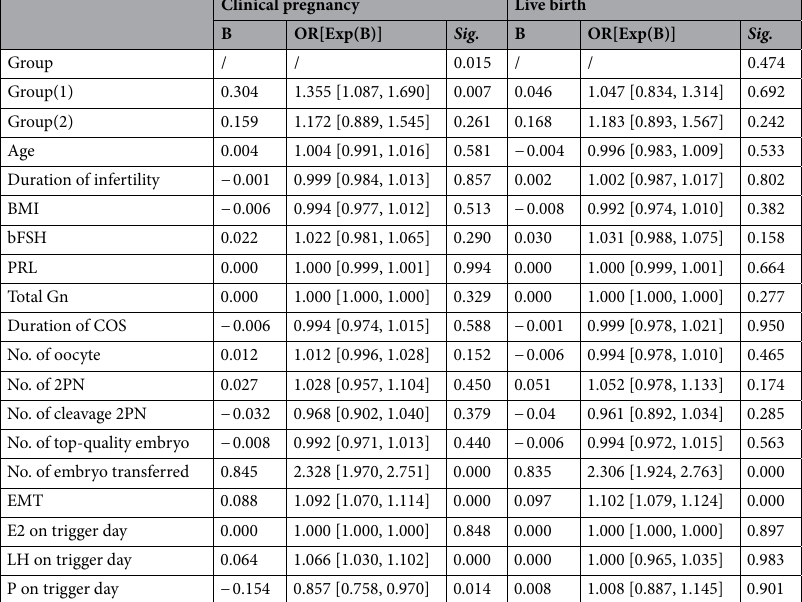
Table 5. Logistic model for clinical pregnancy and live birth after fresh IVF/ICSI-ET.